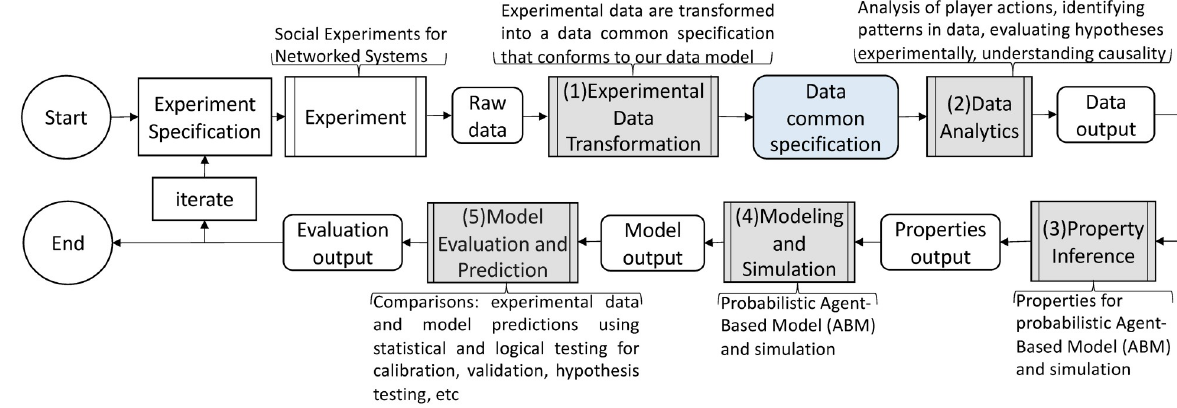
Fig 3. Five software pipelines (in gray) for NESS experiments. The five pipelines are itemized and described in Table 1. In this human-in-the- analysis loop, experiments (upper left in figure) are performed. Any experiment whose data can be cast in terms of the data model specification can be analyzed with this system. These pipelines are the focus of this work. The pipeline composition shown here, for abductive looping, is one of several possibilities. See Table 1 for descriptions of the pipelines in this figure. The first, second, and fifth pipelines can be used with a purely experimental approach (omitting modeling). An earlier version of the pipeline system is provided in [34], Fig 1.